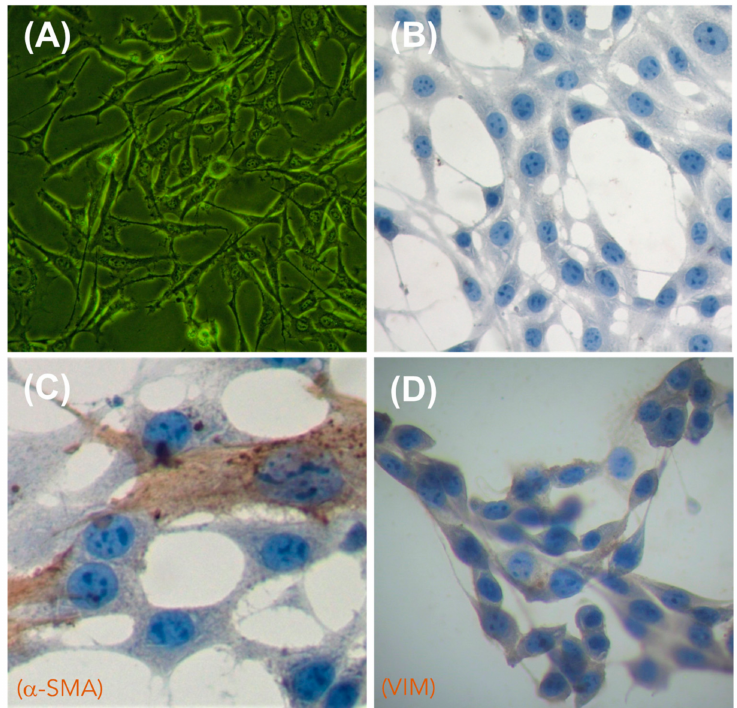
Figure 11. Morphological characterization of 3T3 fibroblasts by inverted microscopy ( A ) and im- munocytochemistry (ICC) ( B – D ). ( A ) Cells observed by inverted microscopy; ( B ) negative ICC control (omission of antibody); ( C ) visualization of alpha smooth muscle actin ( α -SMA, Dako, dilution 1:250), used to mark the cytoskeleton of 3T3 fibroblast; ( D ) visualization of vimentin (VIM, Cell signaling, dilution 1:250), used to mark the cytoskeleton of 3T3 fibroblast. Cells were counterstained with hematoxylin. Images were captured at 40 ×